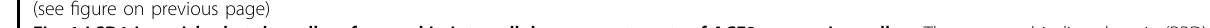
subjected to western blot analysis. The data con fi rmed ACE2 and LSD1 protein expression at the cell surface (Fig. 1c), with the presence of integrin B as a positive control con fi rming membrane protein extraction (Fig. 1c).